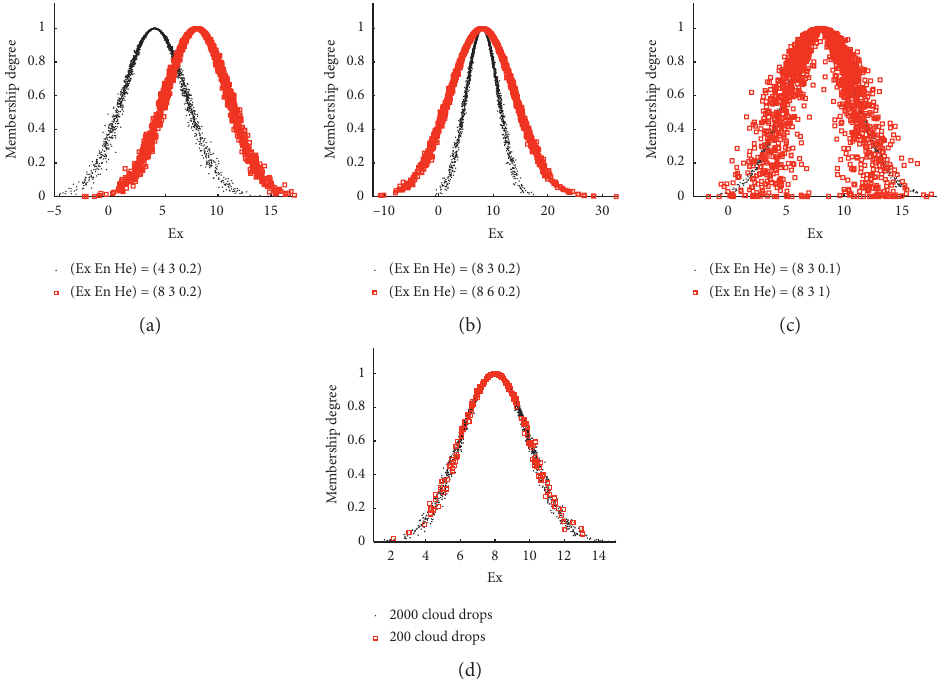
Figure 1: Cloud models with different numerical